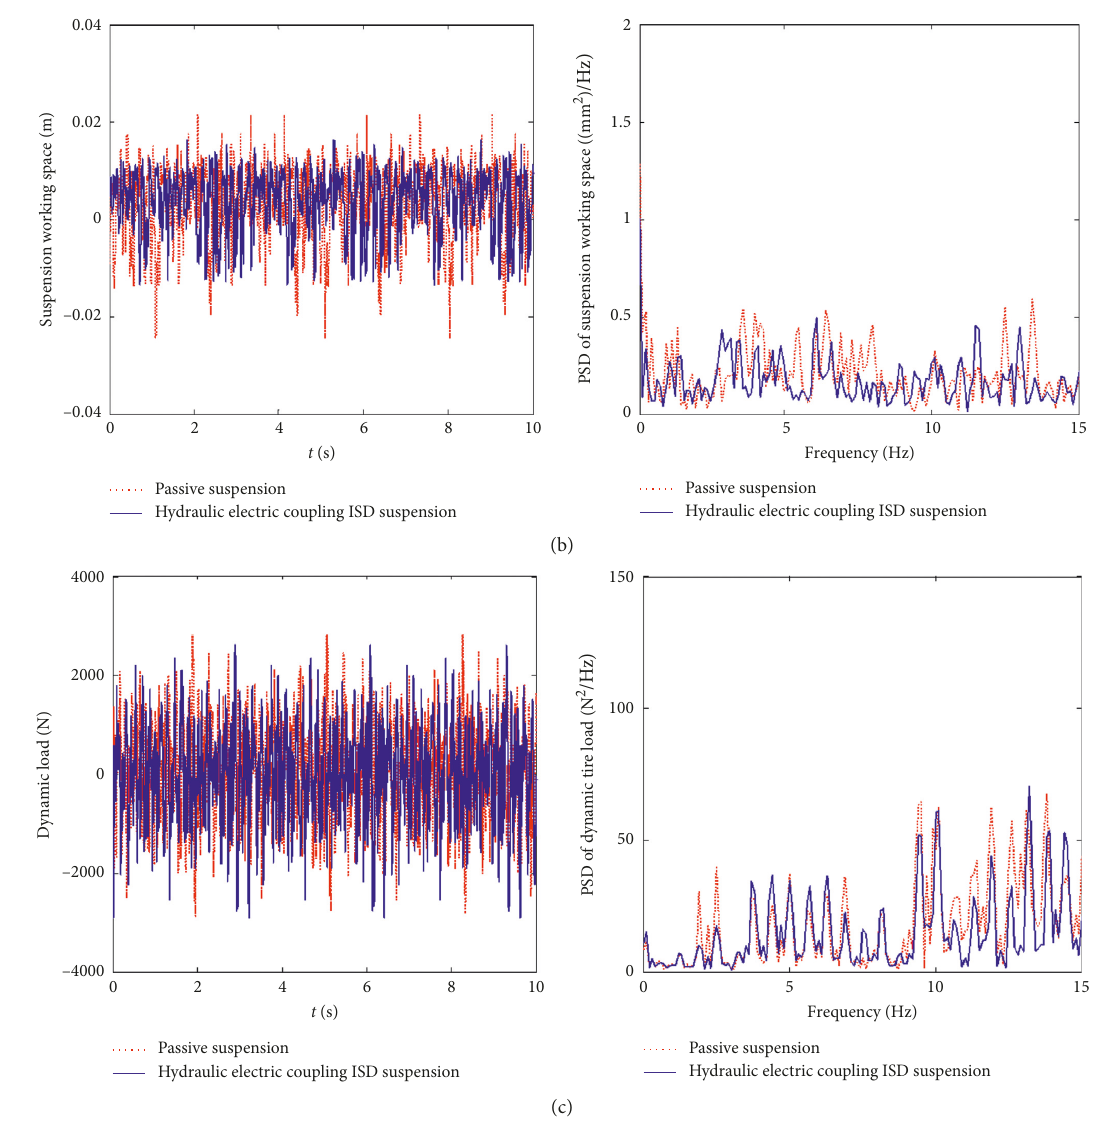
Figure 12: Test performance comparison. (a) Body acceleration. (b) Suspension working space. (c) Dynamic tire load.